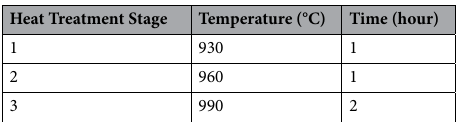
Table 1. Multi-Stage Thermal Oxidation (MSHT)